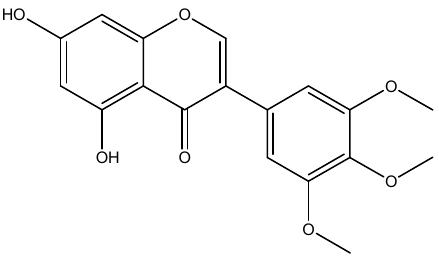
Figure 1. Chemical structure of panchovillin (PANV).